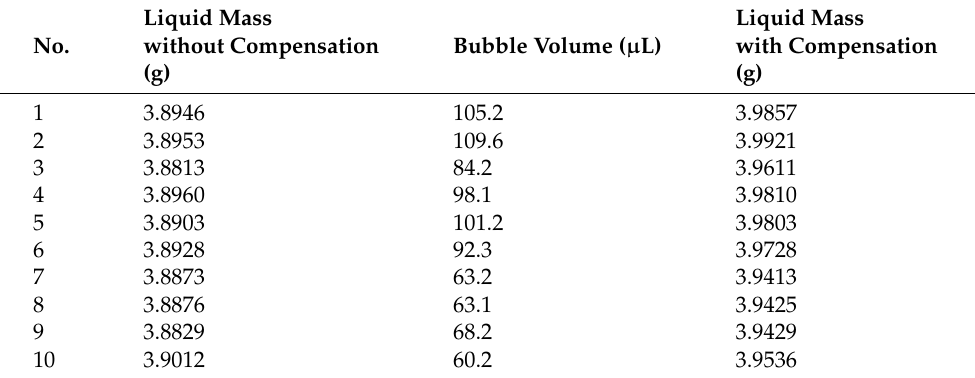
Table 2. Results of the sample-adding experiments using the bubble-detection method for compensa- tion (flow rate: 0.667 mL/s).